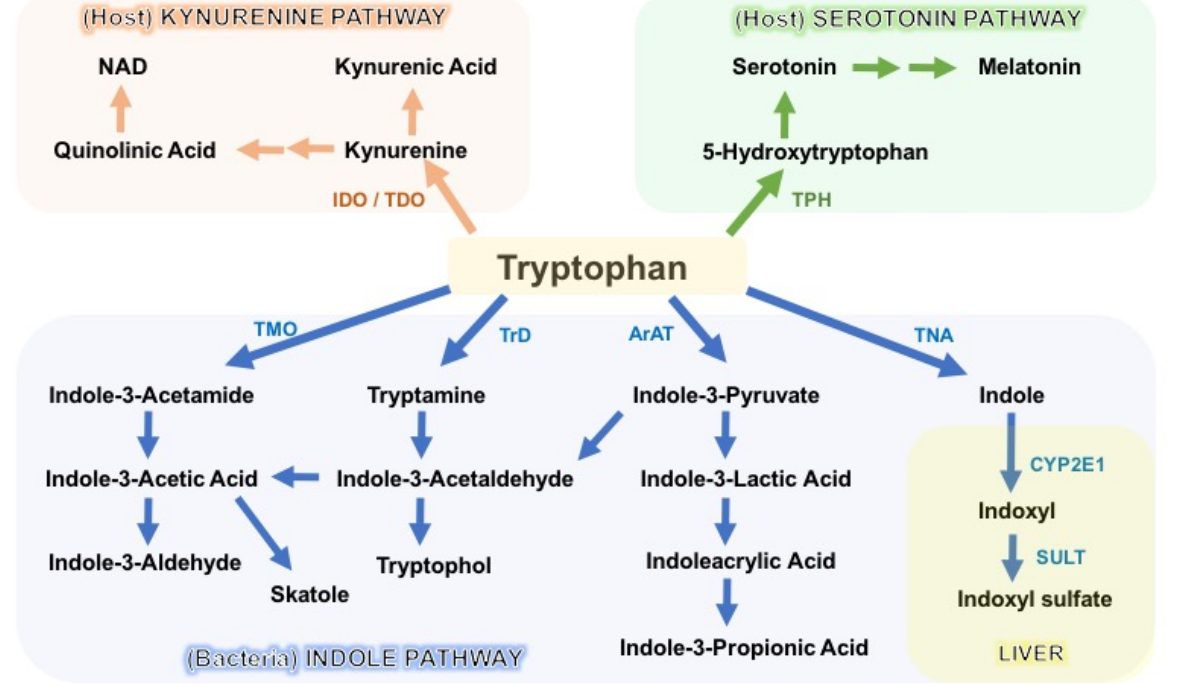
Figure 2. Simplified illustration of the eukaryotic and bacterial pathways of tryptophan degrada- tion in the gastrointestinal tract: Eukaryotic enzymes: IDO (indoleamine 2,3-dioxygemase), TDO (tryptophan 2,3-dioxygemase), TPH (tryptophan hydroxylase), CYP2E1 (cytochrome P450 2E1), SULT (sulfotransferase). Bacterial enzymes: TMO (tryptophan 2-monooxygenase), TrD (tryptophan decarboxylase), ArAT (aromatic amino acid aminotransferase), TNA (tryptophanase), IDO homologs.